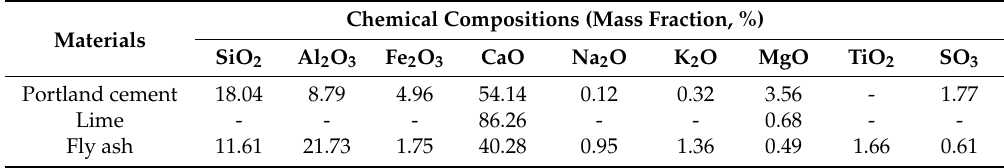
Table 2. Chemical composition of the calcium-based stabilizers.